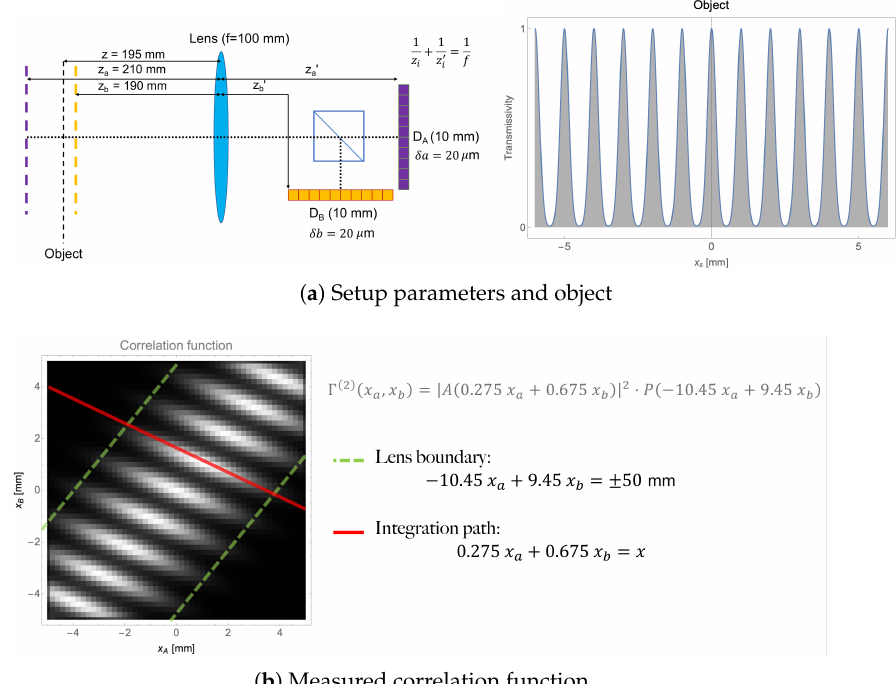
Figure 1. Simulation of a correlation function in the experimental setup shown in panel ( a ). The object is composed of a set of equally spaced 200 µ m-wide gaussian slits, centered 1mm apart from each other. Panel ( b ) shows the two-dimensional quantity that is reconstructed by measuring intensity correlations in the setup shown in panel ( a ). Since the detectors D A and D B are identical strips of 50 pixels each, the result of the measurement is a square matrix of 50 × 50 pixels. However, the optical distances involved and the finite radius of the lens (here fixed at 50mm), prohibits information to be contained in the pixels outside of the two dashed green lines [22]. The red segment, spanning the whole photosensitive area identified by the two detectors, represents the integration path for recovering the information at coordinate x in the object plane. The simulated correlation function is obtained by applying Equation (4) of Ref. [22] to the known object shape A ; the function Φ is defined by the optical distances and components involved. Discretization is then imposed by integrating over the pixel